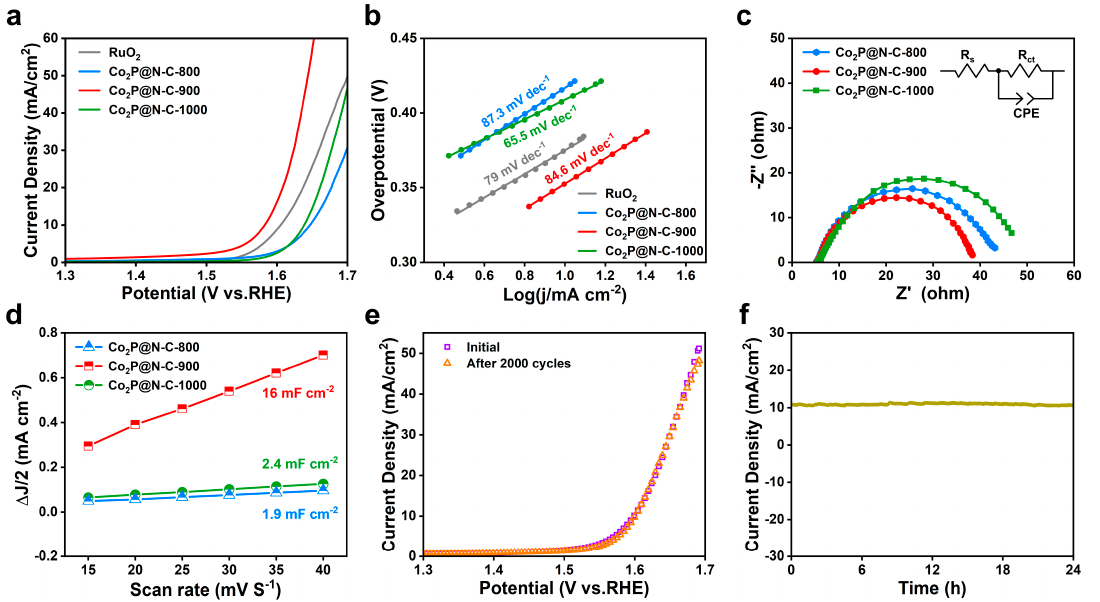
Figure 5. ( a ) OER polarization curves and ( b ) corresponding Tafel plots of Co 2 P@N-C-800, Co 2 P@N- C-900, Co 2 P@N-C-1000 and commercial RuO 2 in 1 M KOH. ( c ) Nyquist plots and ( d ) variation of double layer charging currents as a function of scan rate of Co 2 P@N-C-800, Co 2 P@N-C-900 and Co 2 P@N-C-1000. ( e ) Stability of Co 2 P@N-C-900 electrocatalysts before and after 2000 cycles in 1.0 M KOH. ( f ) Time-dependent current density curves for Co 2 P@N-C-900 at the constant potential for 24 h.